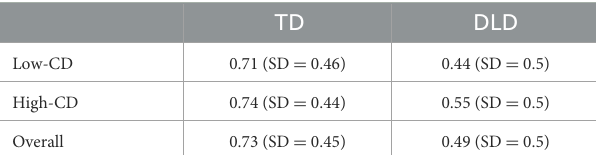
TABLE 2 Descriptive data accuracy off-line test phase.